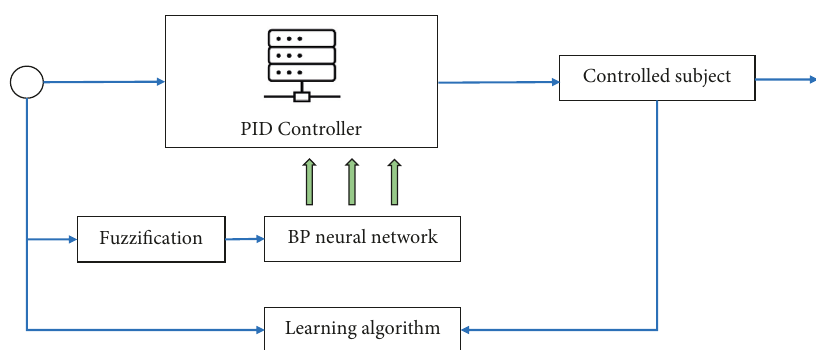
Figure 8: PID controller based on neural networks.